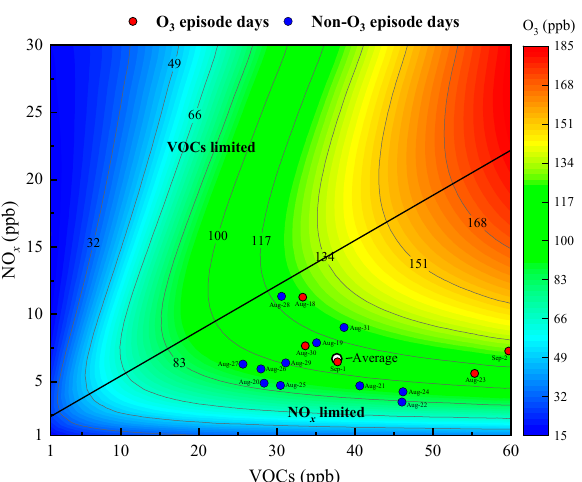
Figure 7. The isopleth diagram modeling the e ff ect on O 3 of NO x and VOCs. The X-axis, Y-axis, and Z-axis represent the VOCs, NO x , and maximum O 3 concentrations, respectively. The red and blue dots denote the observed daily average levels of NO x and VOCs for the O 3 and non-O 3 episode days.